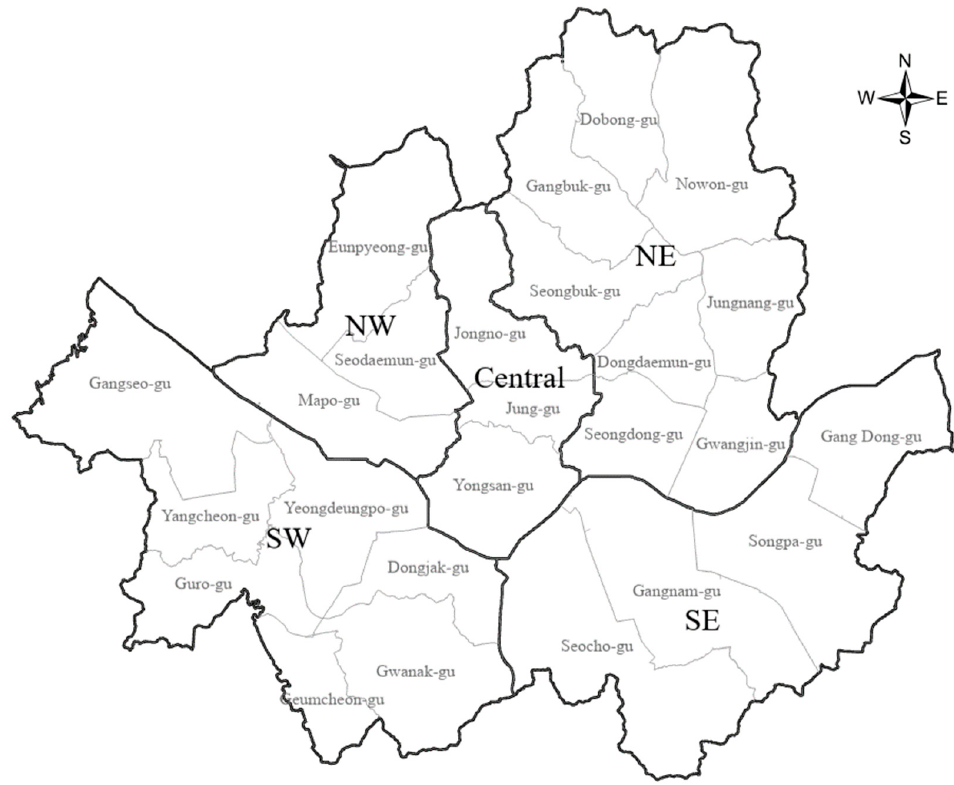
Figure 3. Twenty-five residential neighborhoods and five living areas in Seoul. Figure 3 . Twenty-five residential neighborhoods and five living areas in Seoul. Table 1. Variable Table 1. Variable description.